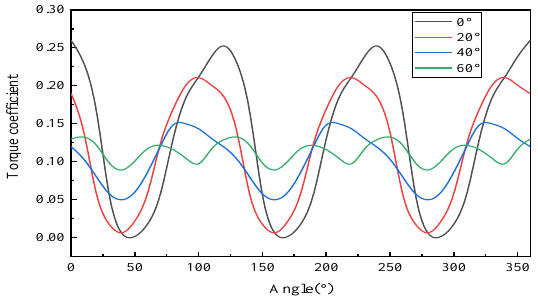
Figure 18. Torque coefficient comparison curves at different stagger angles.